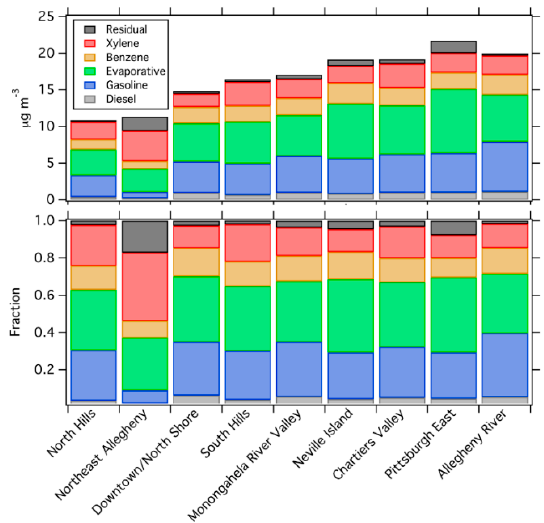
Figure 10. The concentrations and fractions of each PMF factor in each geographic group of sites.